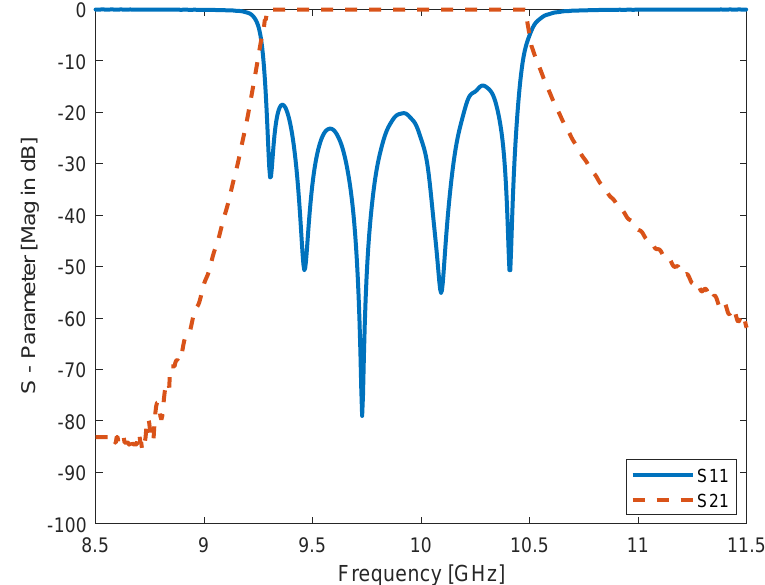
Figure 16. Optimized final response of the proposed waveguide meta-resonator filter and its S-parameters S 11 at − 20 dB and S 21 0.045 dB at center frequency 10 GHz, N =